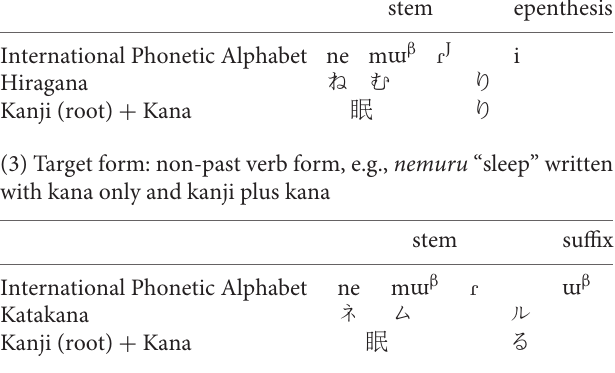
(9) Target form: phonologically-related non-past verb form, e.g., hashiru “run” written with kana only and kanji plus